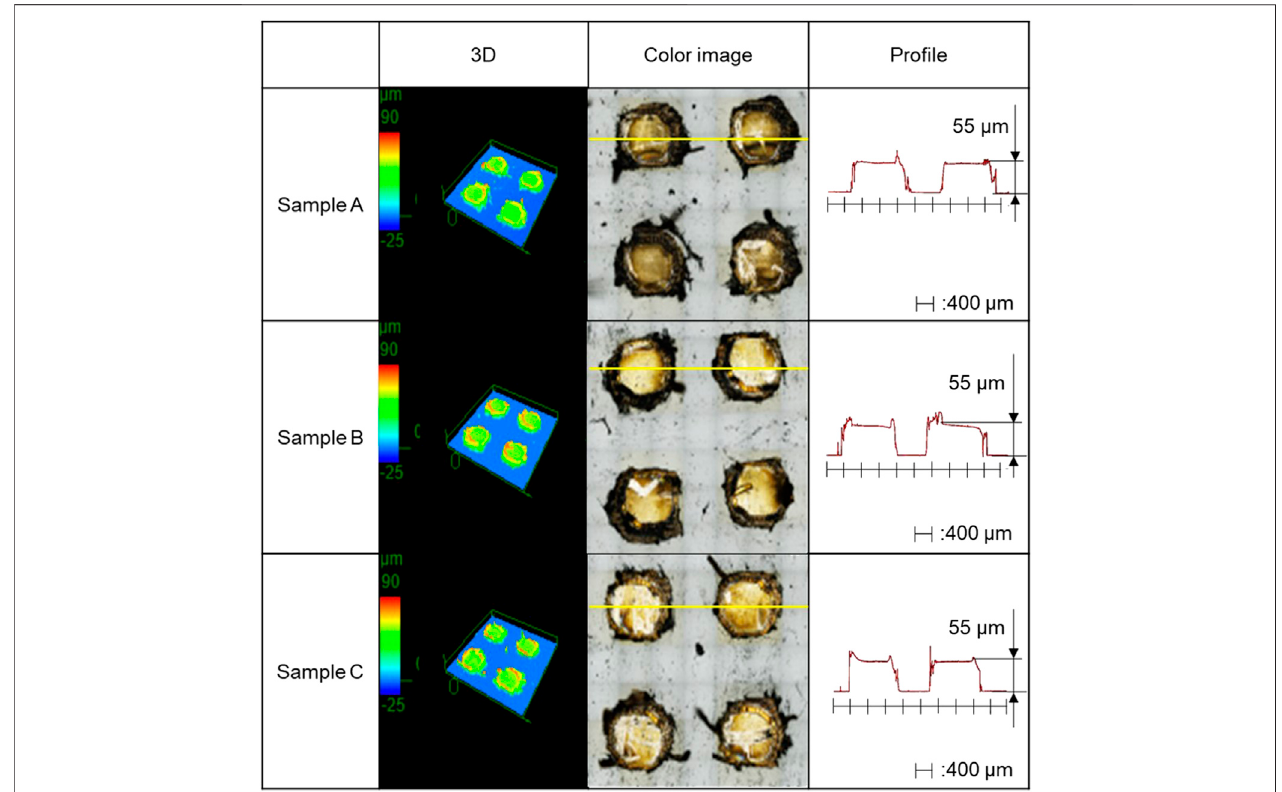
FIGURE 4 | 3D map, color image, and pro fi le of the mask formed on the glass surface.